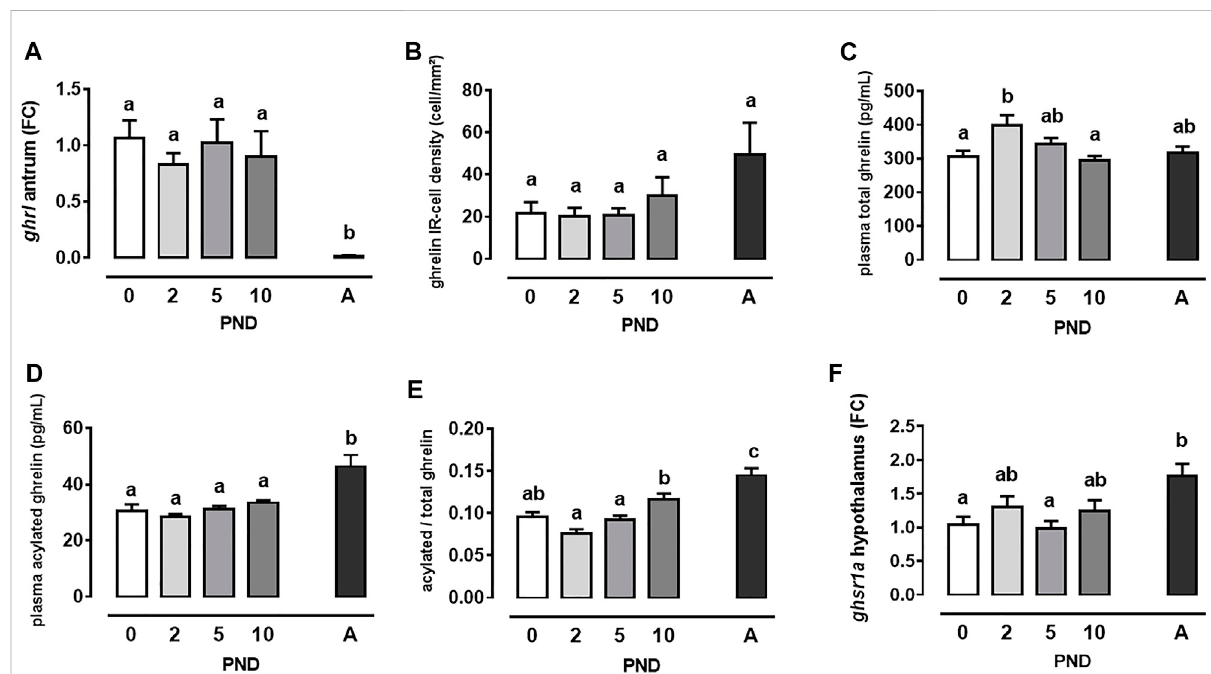
FIGURE 1 Neonatal development of the ghrelin system in mini-pigs. Pre-pro-ghrelin ( ghrl ) mRNA levels in the antrum (A) , density of acylated ghrelin immuno-reactive (IR) cells in the antrum (B) , total (C) and acylated (D) ghrelin plasma level, plasma acylated-to-total ghrelin ratio (E) and ghrelin receptor( ghsr1a )mRNAlevels inthehypothalamus weremeasuredinneonatalsuckledmini-pigs(post-nataldays(PND)0 – 10)andinadultones(A). Data are means +/ − sem. Means with different letters are signi fi cantly different ( p ≤ 0.05, One-way ANOVA followed by Tukey test, n = 9 per group during the post-natal period and n = 6 for